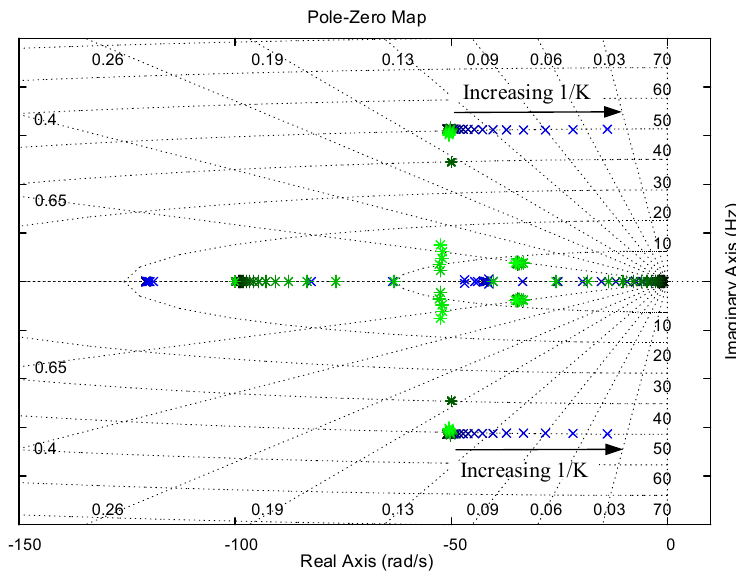
Figure 4. The impact of 1/K (increased from 0.075 to 7.5) and the introduced current lowpass filters on the poles distribution of synchronverter system. Cross: poles without current lowpass filters. Asterisk: poles with current lowpass filters.